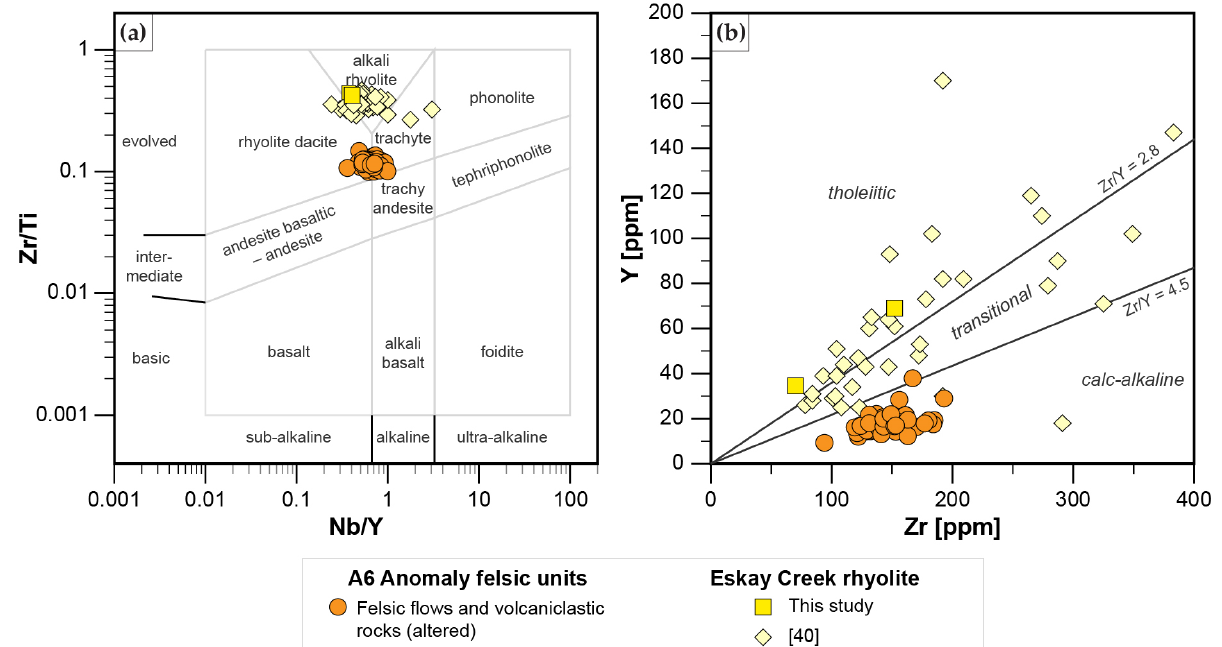
Figure 7. Rock classification and magmatic affinity of altered felsic igneous lithologies at the A6 Anomaly in comparison to samples from Eskay Creek (this study and [40]). ( a ) Nb/Y vs. Zr/Ti rock classification diagram after [57], ( b ) Zr vs. Y magmatic affinity plot for alkaline rocks using Zr/Y ratios of